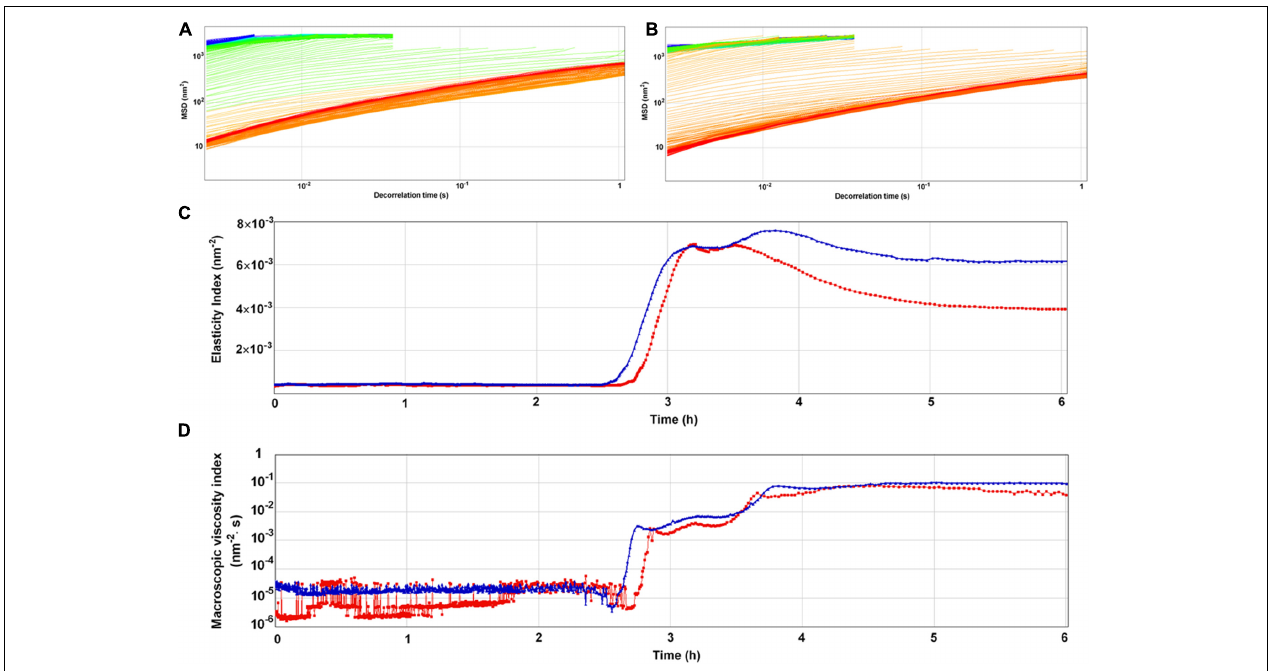
FIGURE 4 | The representative mean square displacement (MSD) curves, elasticity index (EI), and macroscopic viscosity index (MVI) of yogurt produced by S. thermophilus 05epsC. (A) MSD of yogurt produced by S. thermophilus 05CK; (B) MSD of yogurt produced by 05epsC; (C) EI of yogurt produced by 05epsC and 05CK; (D) MVI of yogurt produced by 05epsC and 05CK; Blue triangle: yogurt produced by 05epsC; Red square: yogurt produced by 05CK.